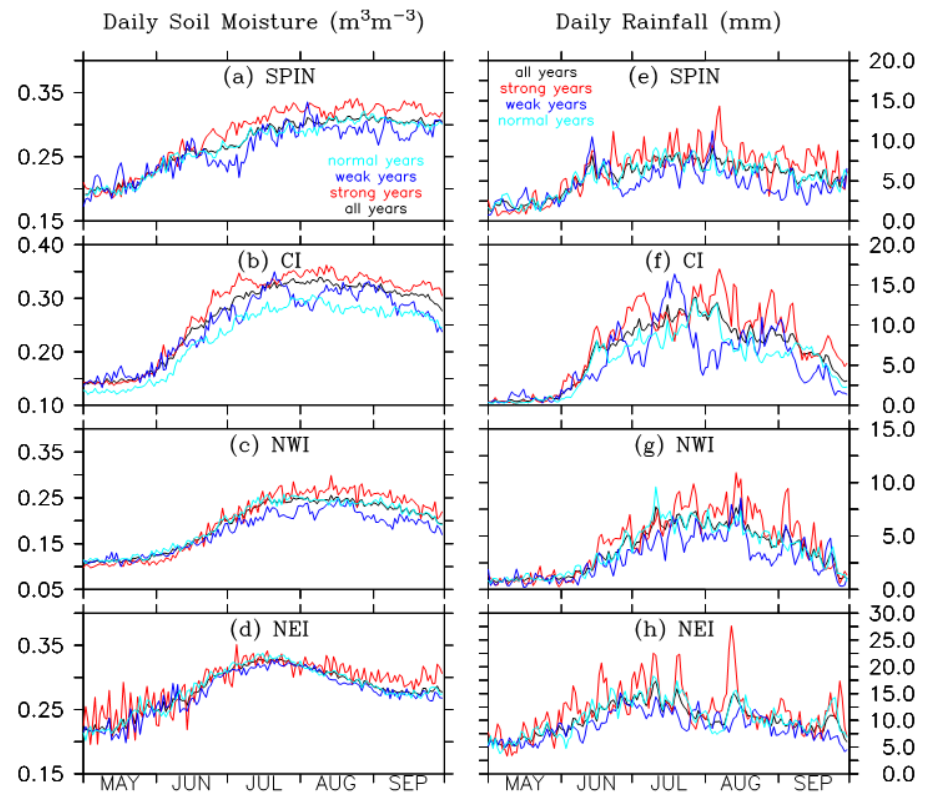
Figure 5. The evolution of daily surface soil moisture ( left ) area averaged over ( a ) SPIN, ( b ) CI, ( c ) NWI, and ( d ) NEI and the evolution of daily rainfall ( right ) area averaged over ( e ) SPIN, ( f ) CI, ( g ) NWI, and ( h ) NEI from May through September for strong (red curve), weak (blue curve), normal (cyan curve) ISM years and all years (black curve). Soil moisture and rainfall daily climatology were computed based on the period 1992–2020. The unit for daily volumetric soil moisture (daily rainfall) is m 3 m − 3